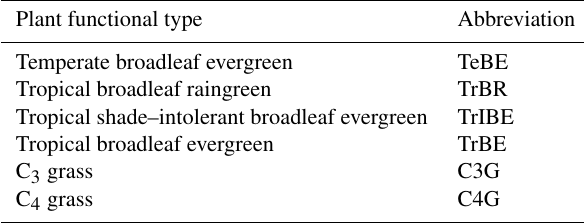
Table 1. List of plant functional types in the standard configura- tion of LPJ-GUESS (only PFTs predicted by the simulations in this study are